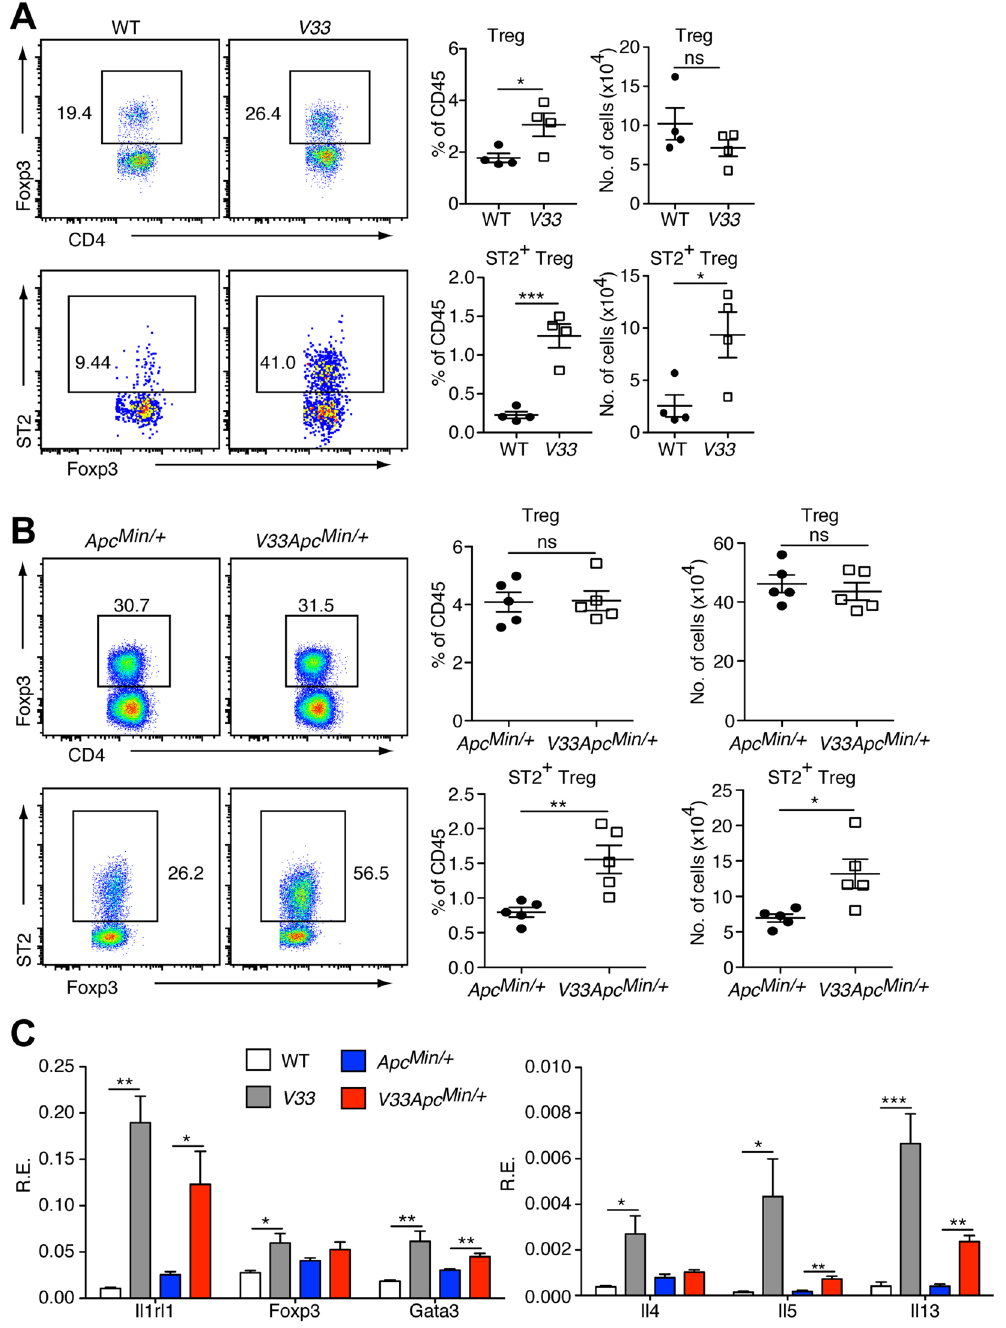
Figure 5. Epithelial-derived IL-33 signaling expands colonic ST2 + regulatory T (Treg) cells and induces a Th2 cytokine profile. ( A ) Relative and absolute number of Treg cells (CD4 + Foxp3 + ) in the colon of Apc Min/ + mice and V33 Apc Min/ + mice at d120. Left, representative flow cytometry plots gated on CD45 + cells; right, statistical data show means ± s.e.m. ( B ) Relative and absolute number of ST2 + Treg cells in the colon of Apc Min/ + mice and V33 Apc Min/ + mice at d120. Left, representative flow cytometry plots gated on CD45 + CD4 + cells; right, statistical data show means ± s.e.m. ( C ) Relative expression levels of ST2 + Treg and Th2 signature genes were analyzed by qPCR in sorted T cells of colonic lamina propria of WT, V33 , Apc Min/ + mice and V33 Apc Min/ + mice at d120. Graphs show means ± s.e.m., n = 4–5/group. * P < 0.05, ** P < 0.01, *** P < 0.001, one-way